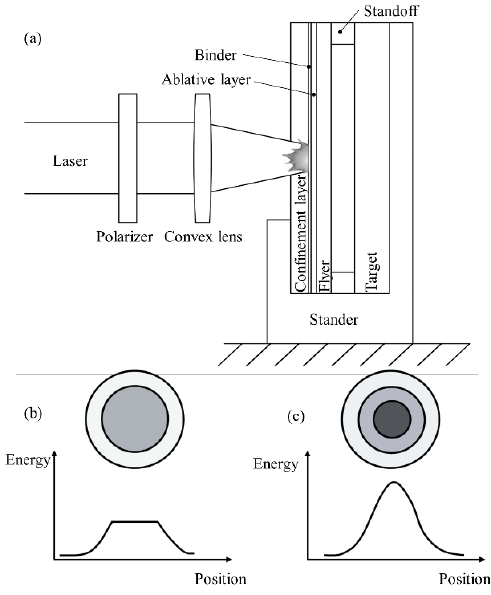
Figure 3. ( a ) Schematic diagram of laser impact welding system; ( b ) flat-top laser energy distribution; ( c ) Gaussian laser energy distribution.